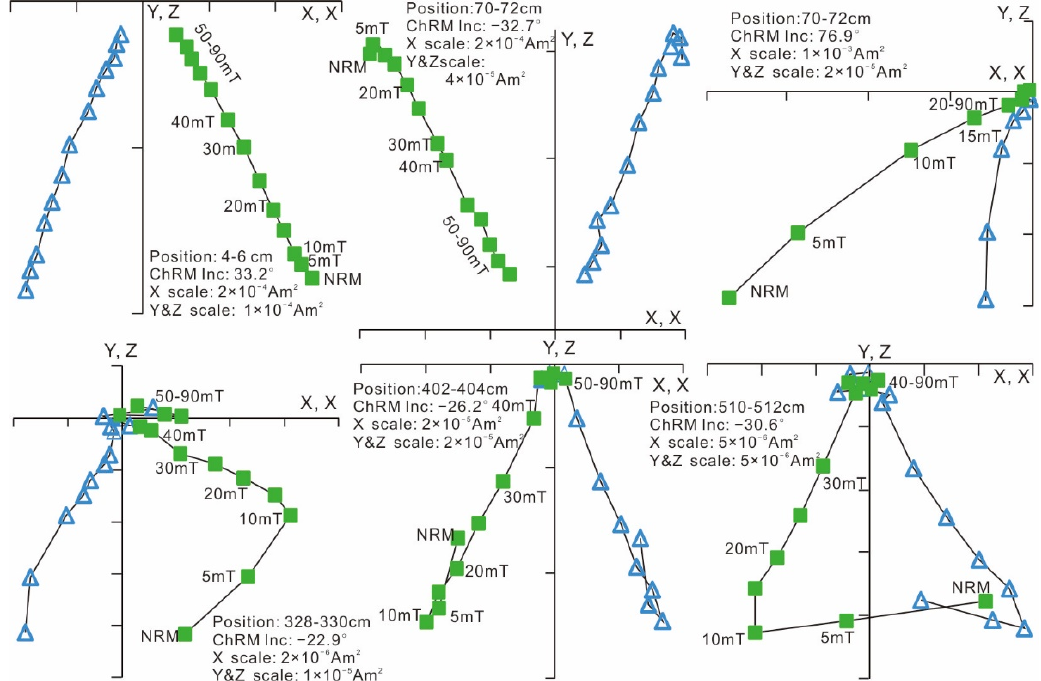
Figure 3. Orthogonal diagrams of the stepwise AF demagnetization of representative samples. Open triangles represent the horizontal planes, while solid squares represent vertical